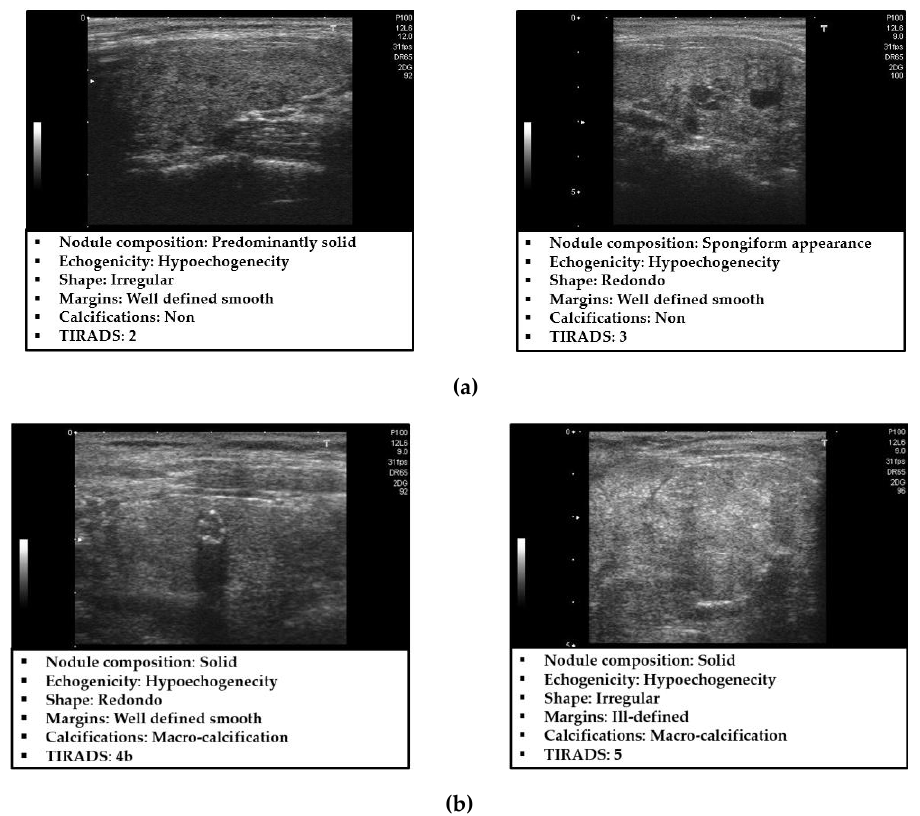
Figure 1. Example of captured ultrasound thyroid images in the thyroid digital image database (TDID) dataset [20]: ( a ) benign cases and ( b ) malign cases.